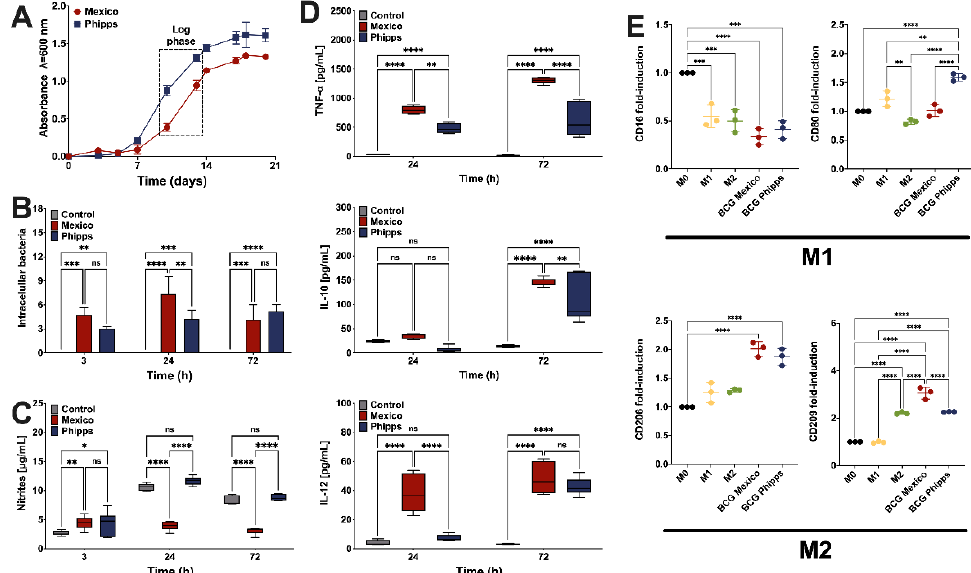
Figure 1. The bacterial growth and the immune characterization. For the growth curves of BCG strains: ( A ) the logarithmic (log) phase was determined at days 10–11 for both strains and is indicated in a dotted rectangle. The survival of the BCG strains in THP-1 macrophages ( B ) was tested at 3, 24 and 72 h postinfection. The nitric oxide production at progressive times by macrophages infected with the BCG strains, or in presence of the control, can be seen in ( C ). The concentrations of TNF- α , IL-10 and IL-12 in the supernatants of THP-1 macrophages infected with the BCG strains 24 h and 72 h postinfection, or of noninfected THP-1 cells, is shown in ( D ). The presence of the surface markers CD16 and CD80, or CD206 and CD209, related to M1 and M2 macrophages, respectively, is seen in ( E ). Data is expressed as means ± s.d. M0: M0 macrophages; M1: M1 macrophages; M2: M2